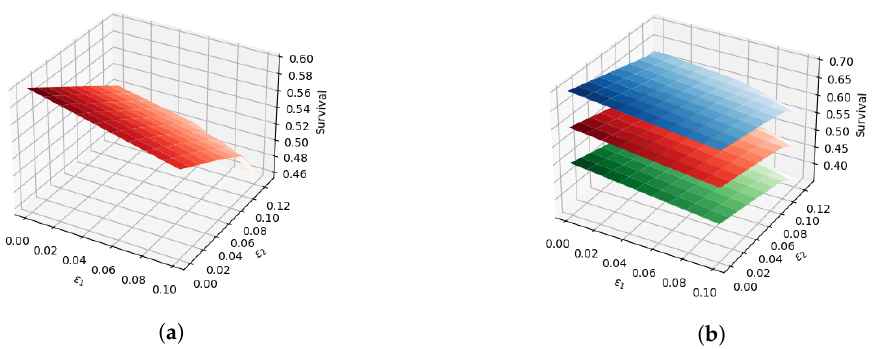
Figure 1. Case Study-2 , Pareto surfaces. ( a ) Formulation (12a–f) Pareto. ( b ) Formulations (12a–f)– (14a–f) Pareto surfaces. Table 5. Minimax game values (at ε 1 = ε 2 = 0) of Case